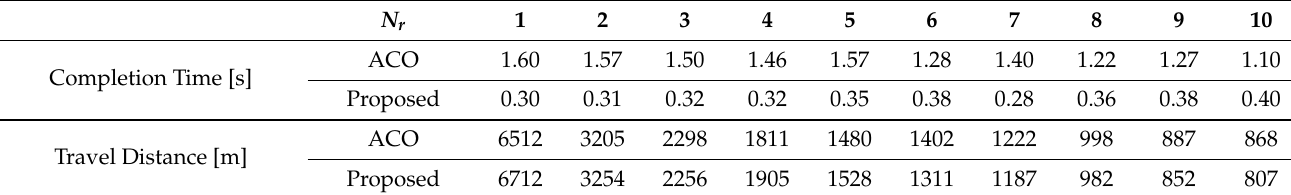
Table 3. Comparison of algorithm performance of the proposed order sequencing method. N